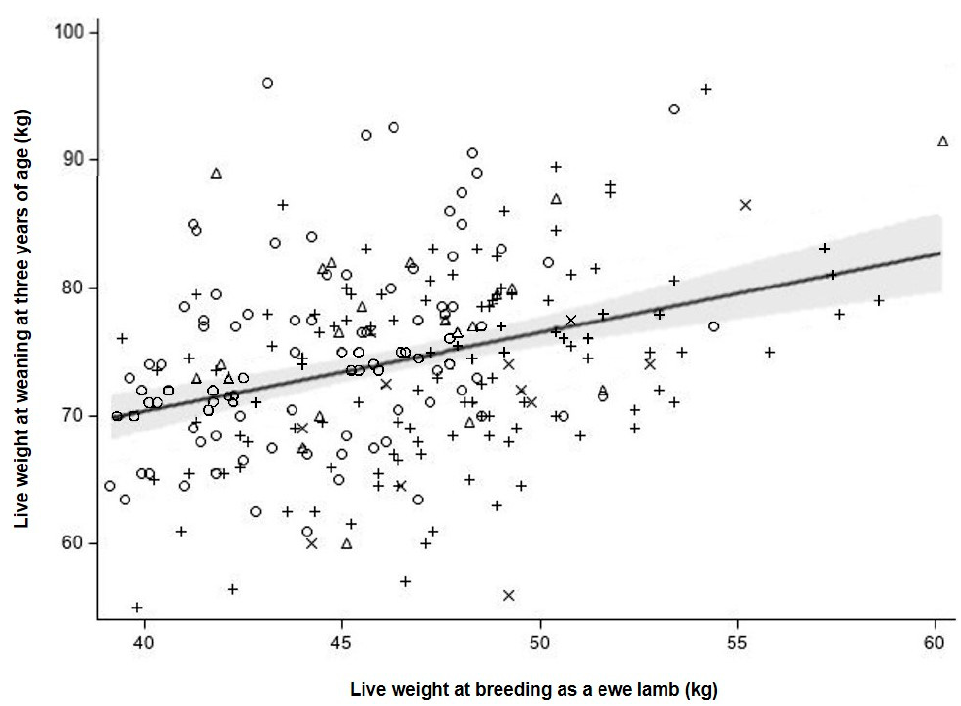
Figure 6. Ewe live weight at weaning at 39 months of age (d1159) in relation to their live weight at their first breeding at seven months of age (d213) displaying their status (failed to wean a lamb (triangles) or not pregnant (circles)) and pregnancy rank (single-bearing (plus) or twin-bearing (crosses)) as a ewe lamb. Predictions and 95% confidence intervals are shown .